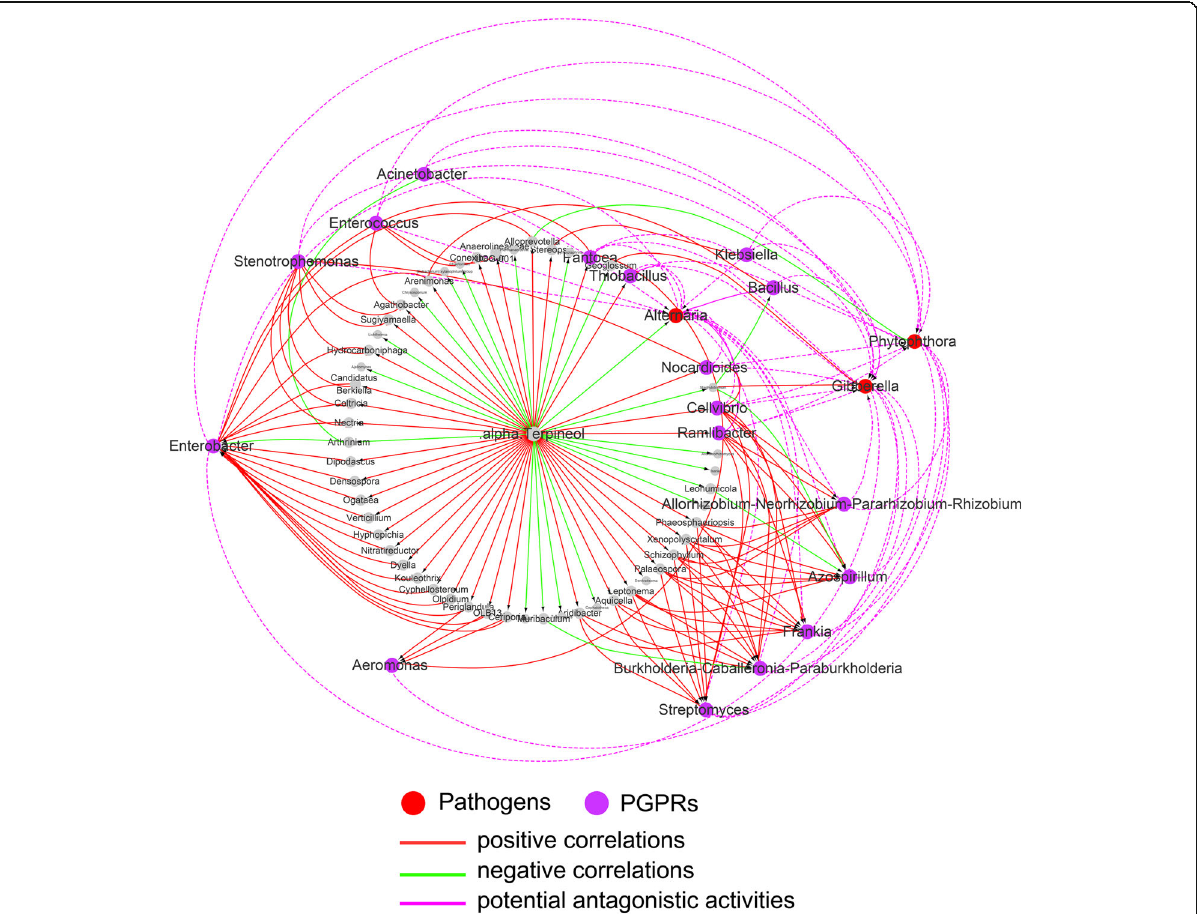
Fig. 6 Subnetwork of 56 genera of fungi and bacteria directly or indirectly correlated with the increase of α -terpineol, including fungal pathogens and previously isolated or widely reported PGPRs. Purple and red circles represent PGPRs and pathogens, respectively. Red and green lines indicate positive and negative correlations, respectively. The purple line represents the potential antagonistic activities of PGPRs against pathogens. Solid and dotted lines indicate significant and nonsignificant correlations,